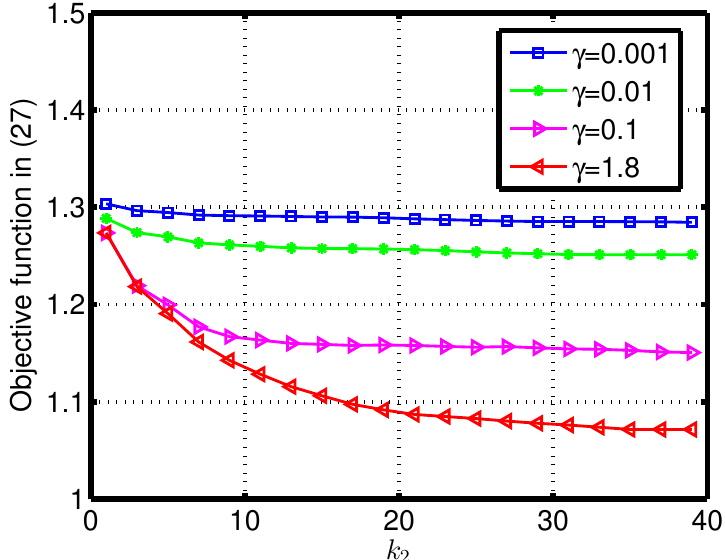
Figure 2. The objective value with outer iteration number under different similarity parameter γ